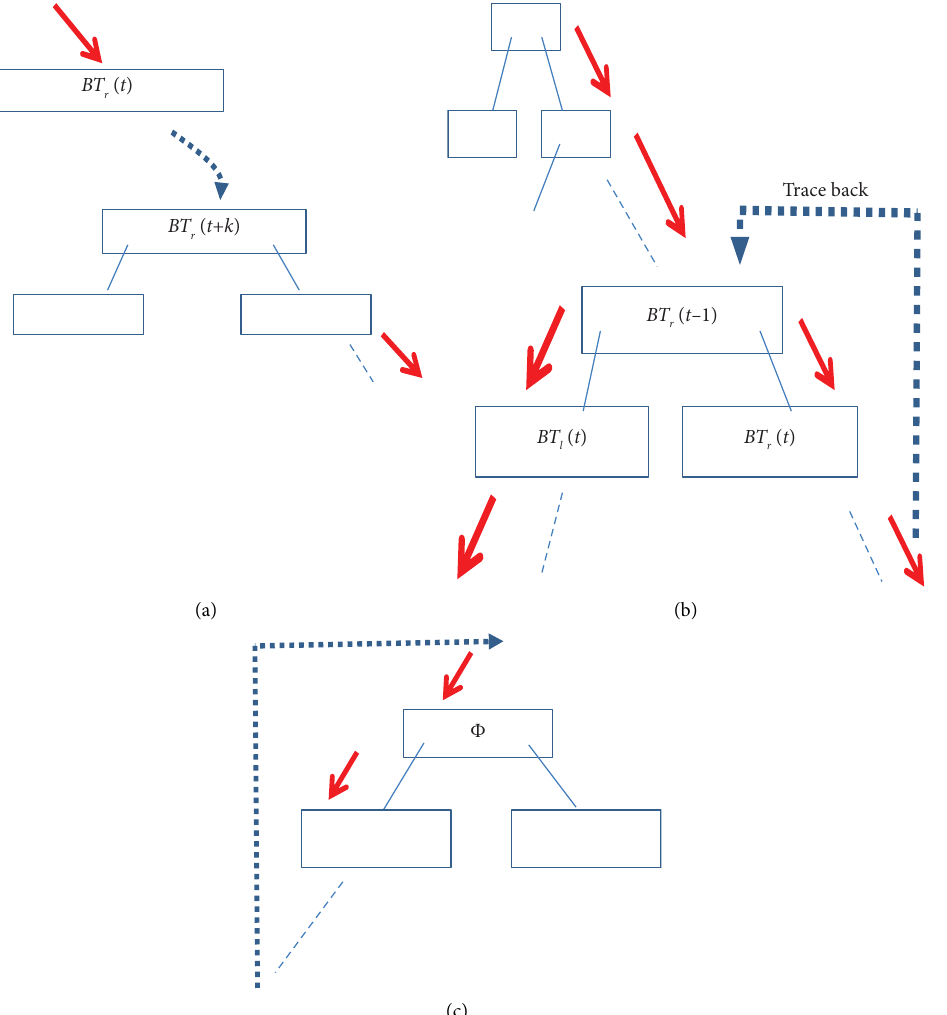
Figure 4: Back trackable binary tree depth-frst search